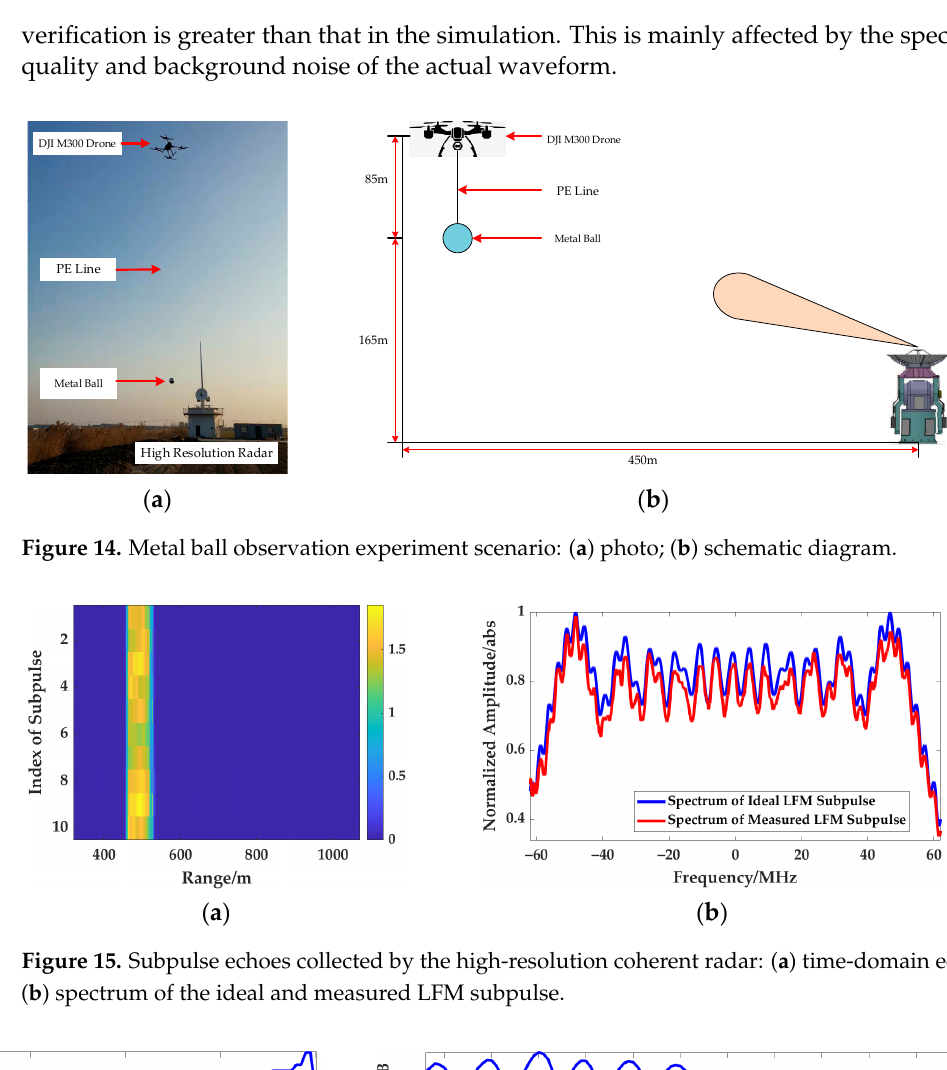
oes; ( b ) spectrum of the ideal and measured LFM subpulse. ( b ) spectrum of the ideal and measured LFM subpulse.